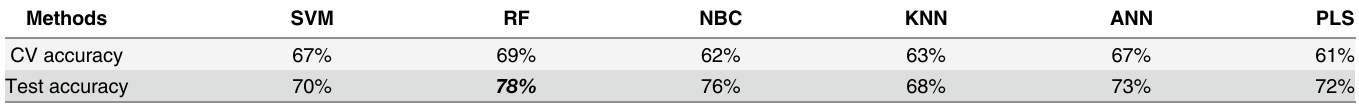
Table 11. Non-redundant ddG ternary classification (training and test data sets were selected by protein).